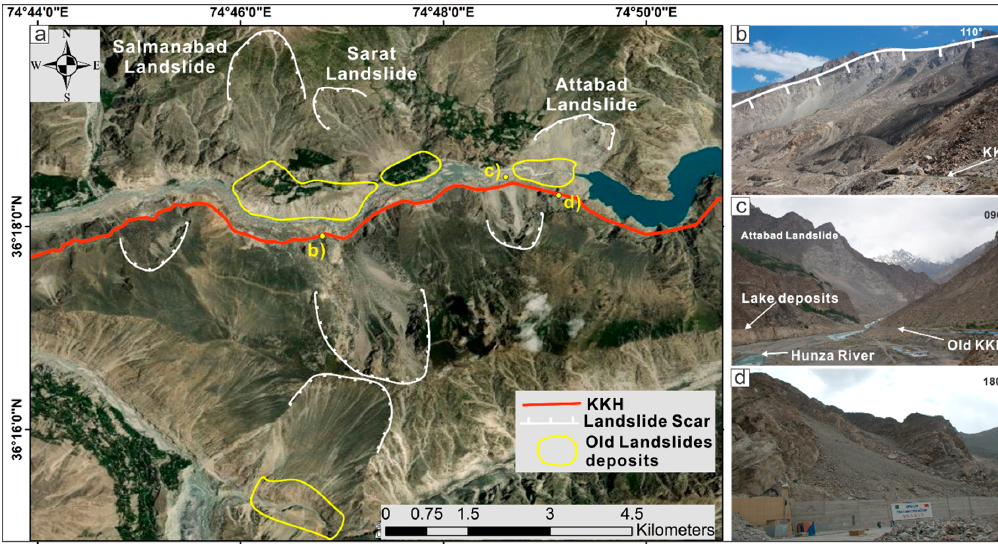
Figure 2. (a) Overview of old landslides scars near to Attabad Lake: white lines are representing the main scarps of old large landslides/rock avalanches; yellow polygons represent deposits of these old landslides, points b, c, and d show old landslides in the area.